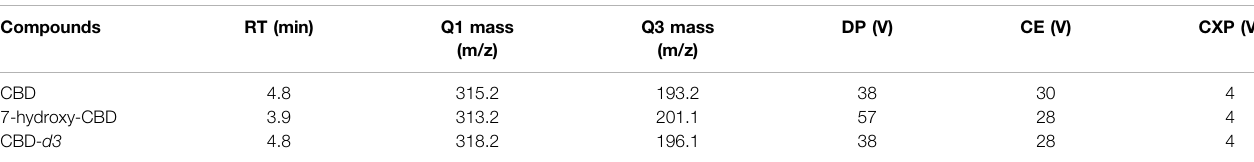
TABLE 1 | Mass spectrometry parameters for CBD, 7-hydroxy-CBD and IS.